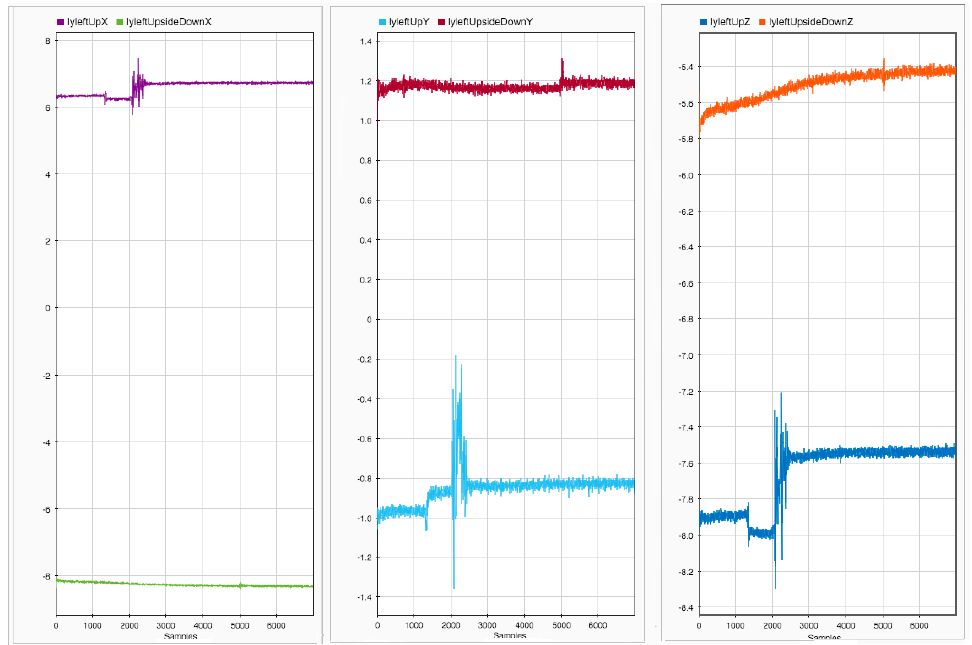
Figure 4. Accelerometer readings for activities lying left collected by keeping the smartphone in RPT, holding the device upright and turning it upside